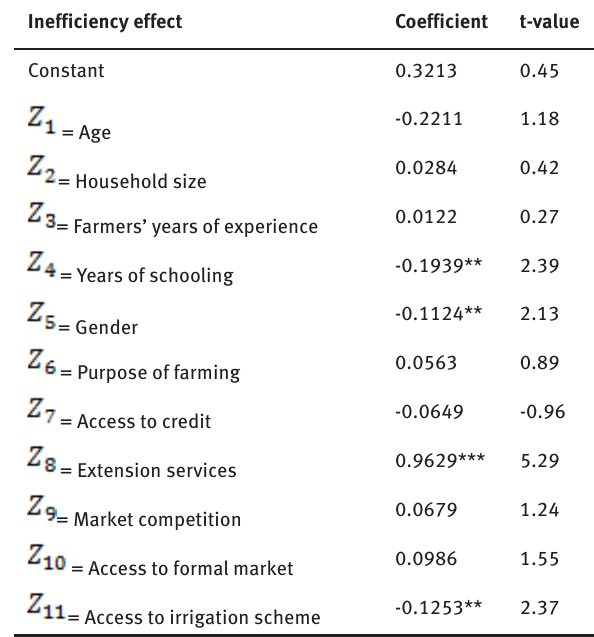
Efficiency level